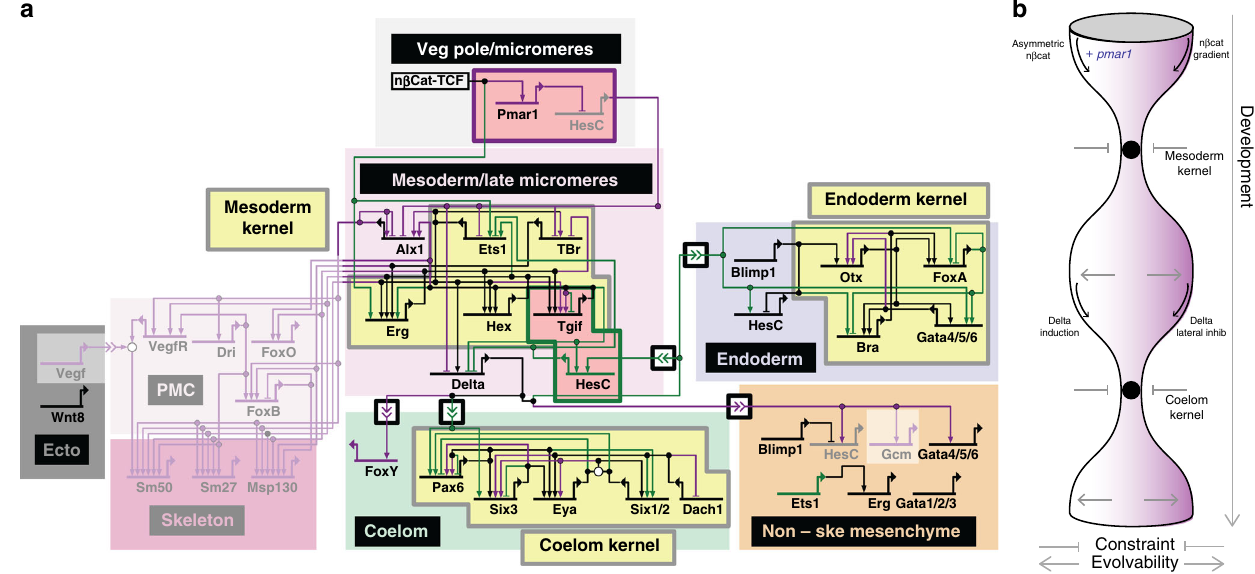
Fig. 6 Evolutionary constraint of network kernels permits alterations to the surrounding network. A synthesis of key aspects of the GRN from sea urchins and sea stars is shown ( a ). Genes (nodes) are shown in the territories (colored boxes) in which they are expressed. Edges show regulation by the originating upstream factor and are either positive (arrow) or repressive (bar). Signaling across cell types are indicated as double arrow heads, and Delta to Notch signals are boxed. Genes and links that are unique to sea urchin embryos are colored purple, those speci fi c to sea stars are green, and those in common are black. Network kernels are highlighted (yellow) as are distinct sub-circuits (pink), including the sea urchin-speci fi c double-negative gate (i.e., Pmar and HesC, purple outline) and sea star-speci fi c positive regulation of HesC (i.e., Tgif and HesC, green outline). Grayed out backgrounds indicate entire network circuits that are absent in sea stars. Our model of GRN evolution is depicted ( b ) showing that network kernels are constrained regions whereas both up and down the hierarchy the network is capable of